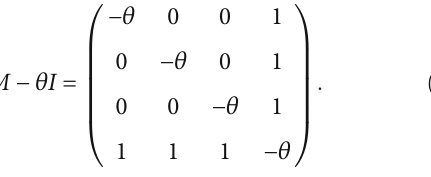
Figure 4: The graphs X